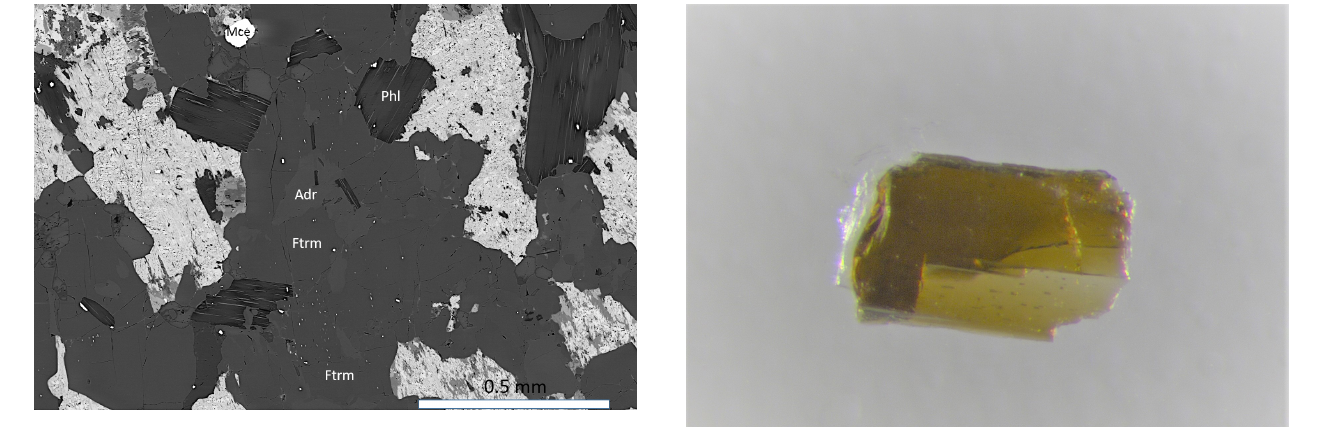
Figure 3. Ferri-taramite with phlogopite, andradite (Adr) and mace- donite (Mce). The irregular brighter areas correspond to altered Ba- feldspar. Sample GEO-NRM #19221254.